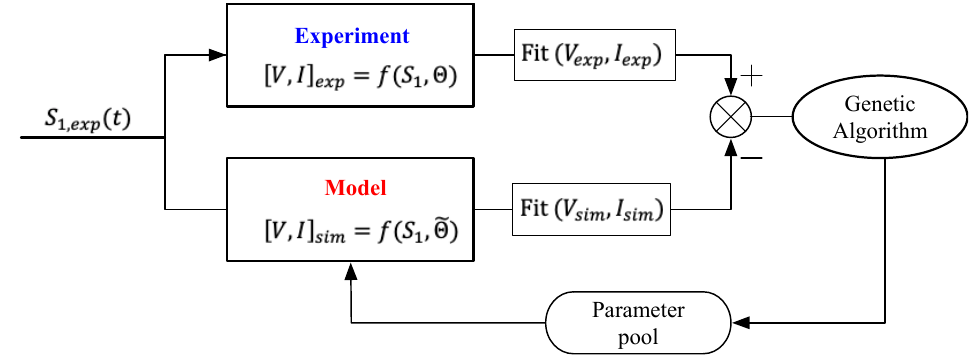
Figure 12. GA flowchart of parameter estimation for the electromechanical model .